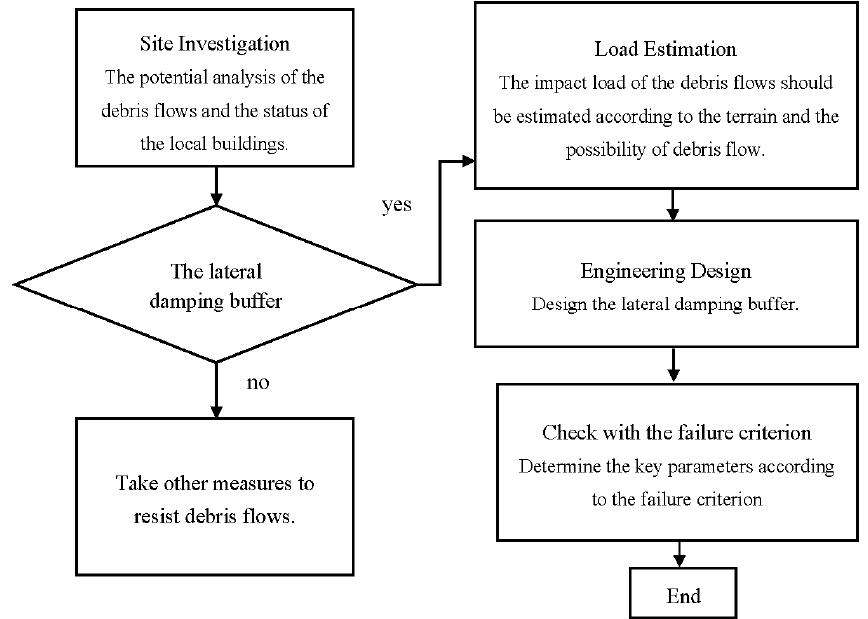
Figure 13. The design process of the lateral damping buffer in resisting debris flows.